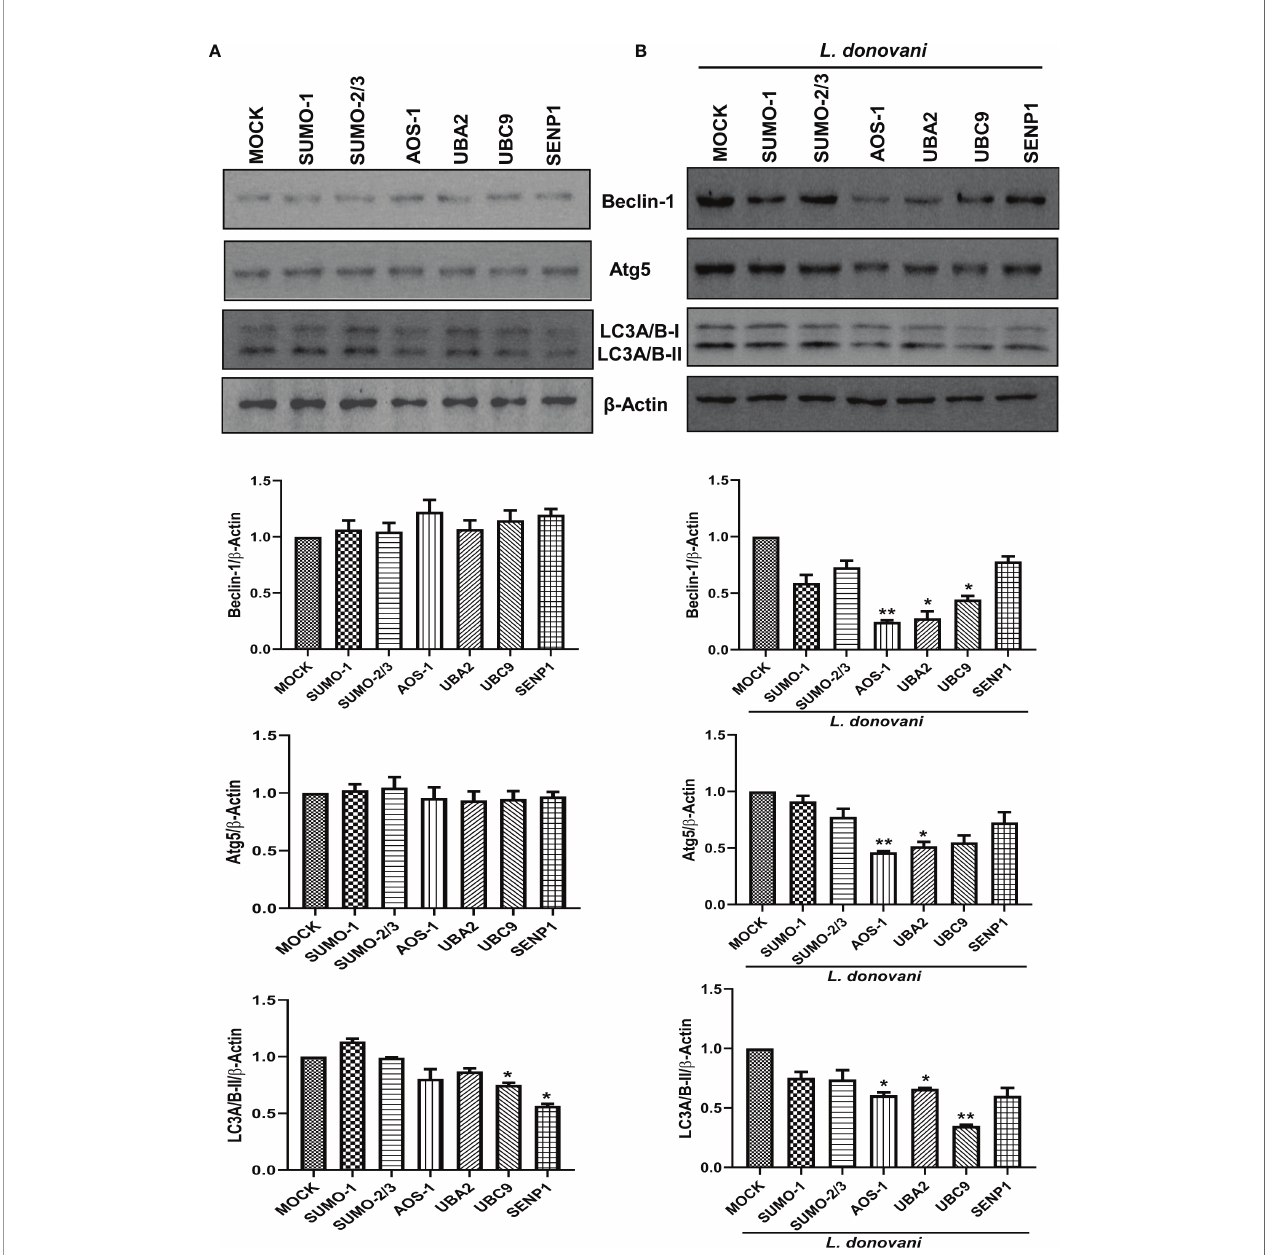
FIGURE 3 | Host SUMOylation regulates the growth of Leishmania donovani by modulating autophagy initiation. (A) 1 × 10 6 THP-1 cells were differentiated into macrophages and were transfected with the speci fi c siRNAs (B) followed by L. donovani infection. MOCK here represents the transfection with a control siRNA. Cell lysates were prepared at 48 h post-infection and were processed to check the expression level of different autophagy markers Beclin-1, Atg5, and LC3A/B. Data from one of three experiments are shown. Band intensities were quanti fi ed by ImageJ software and were plotted in GraphPad Prism 8. Statistical signi fi cance was quanti fi ed using the unpaired t-test with Welch ’ s correction, (A) * p = 0.03 and 0.016 for MOCK vs. UBC9 and SENP1 , respectively, for the expression of LC3A/B-II. (B) * p = 0.038 and 0.018 for MOCK vs. UBA2 and UBC9 , respectively, and ** p = 0.01 for MOCK vs. AOS-1 for the expression of Beclin-1; * p = 0.035 and 0.043 for MOCK vs. UBA2 and UBC9 , respectively, and ** p = 0.01 for MOCK vs. AOS-1 for the expression of Atg5; * p = 0.027 and 0.011 for MOCK vs. AOS-1 and UBA2 , respectively, and ** p = 0.006 for MOCK vs. UBC9 for the expression of